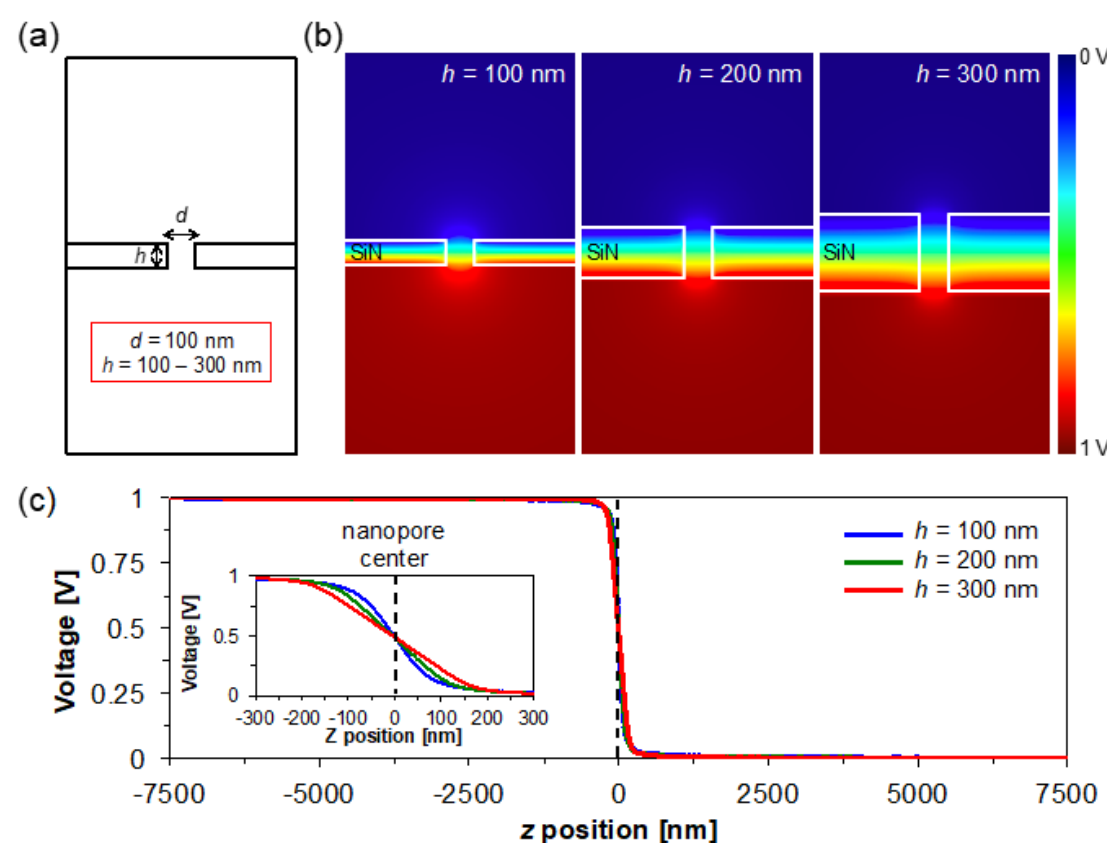
Figure A1. Simulation results for the conventional cylindrical nanopore structures. ( a ) Schematic illustration of the simulation model. ( b ) Cross-sectional potential distributions at y = 0 for the nanopores with h = 100 nm, 200 nm, and 300 nm. ( c ) Potential dependences on the z position on the center axis ( x = 0, y = 0) for the nanopores with h = 100 nm (blue), 200 nm (green), and 300 nm (red), and enlarged view near z = 0 (inset). The potential drops are respectively 0.55 V, 0.69 V, and 0.78 V inside the nanopores with h = 100 nm, 200 nm, and 300 nm. The full electric field gradients of 0–1.0 V exist within z = − 200–200 nm in the present structures (Figure A1c), meaning that analytes suspended more than 200 nm above the nanopore center ( z = 0) cannot pass through a nanopore by electrophoresis unless analytes at a distance greater than the capture radius di ff use into the region incidentally by Brownian motion. These results are comparable to previous reports about the conventional cylindrical nanopore structures